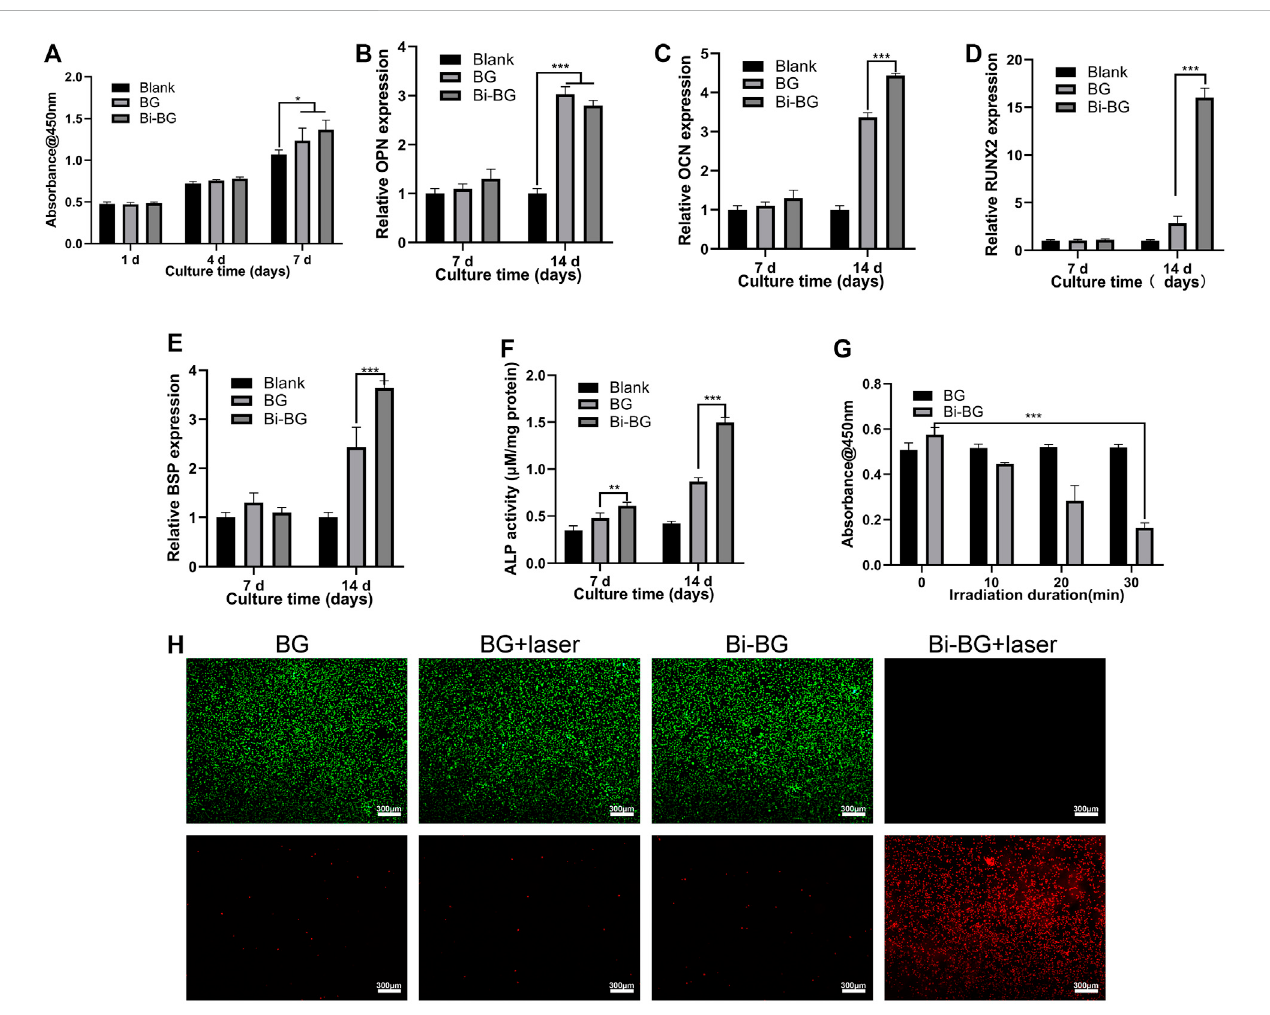
FIGURE 3 In vitro osteogenic and tumor-killing assays. (A) Proliferation of rBMSCs incubated on BG and Bi-BG scaffolds for 1, 4, and 7 days; (B) osteogenic expression of OPN, (C) OCN, (D) Runx2, and (E) BSP, and (F) ALP activity of rBMSCs on the scaffolds for 7 and 14 days ( n = 3). (G) Saos-2 cell viability of on BG andBi-BGscaffoldstreatedwithdifferentirradiationduration; (H) fl uorescentimagesofSaos-2cellsinfourgroupsafter15 minoflaserirradiationat3 W/cm 2 . Green represents live cells and red dead (*, **, and *** indicate p < .05, p < .01, and p < .001,